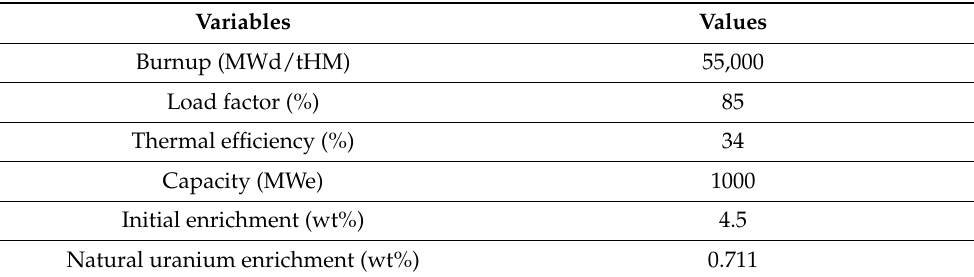
Table 4. PWR specifications.